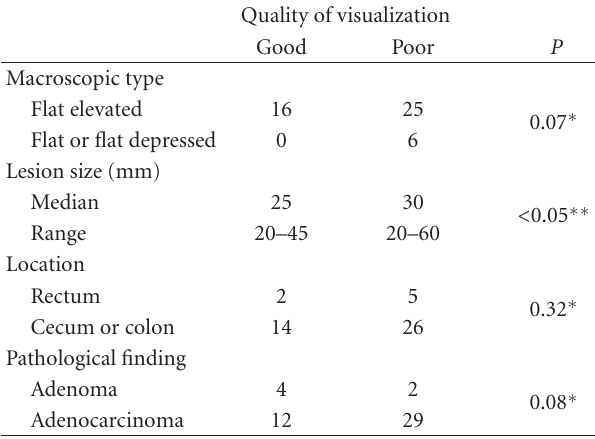
Figure 6: Visualization of LST-G in group